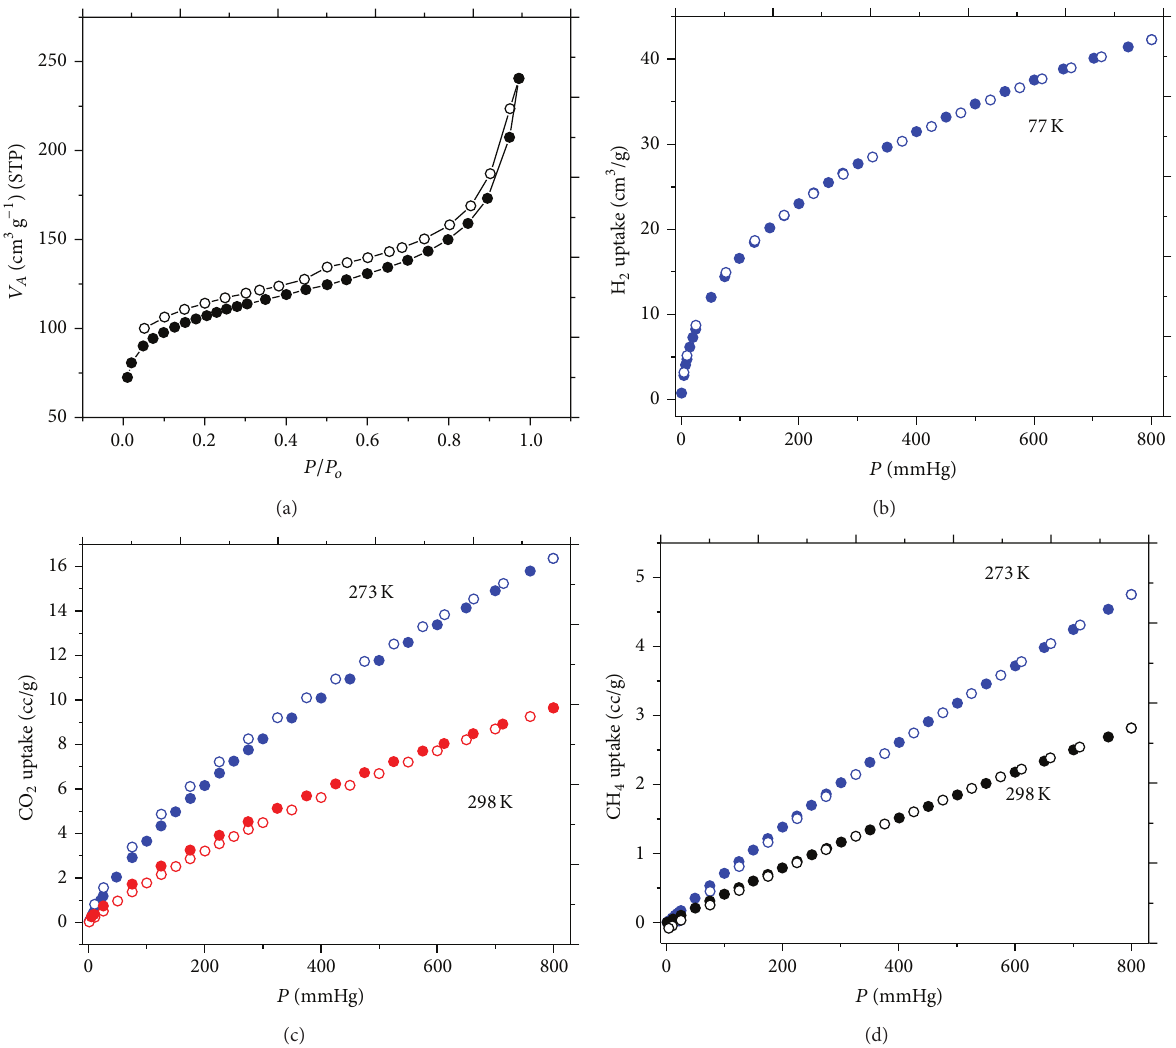
Figure 6: (a) N 2 at 77 K, (b) H 2 at 77 K, (c) CO 2 at 273 K and 298 K, and (d) CH 4 at 273 K and 298 K. Adsorption (filled symbols) and desorption (empty symbols) isotherm